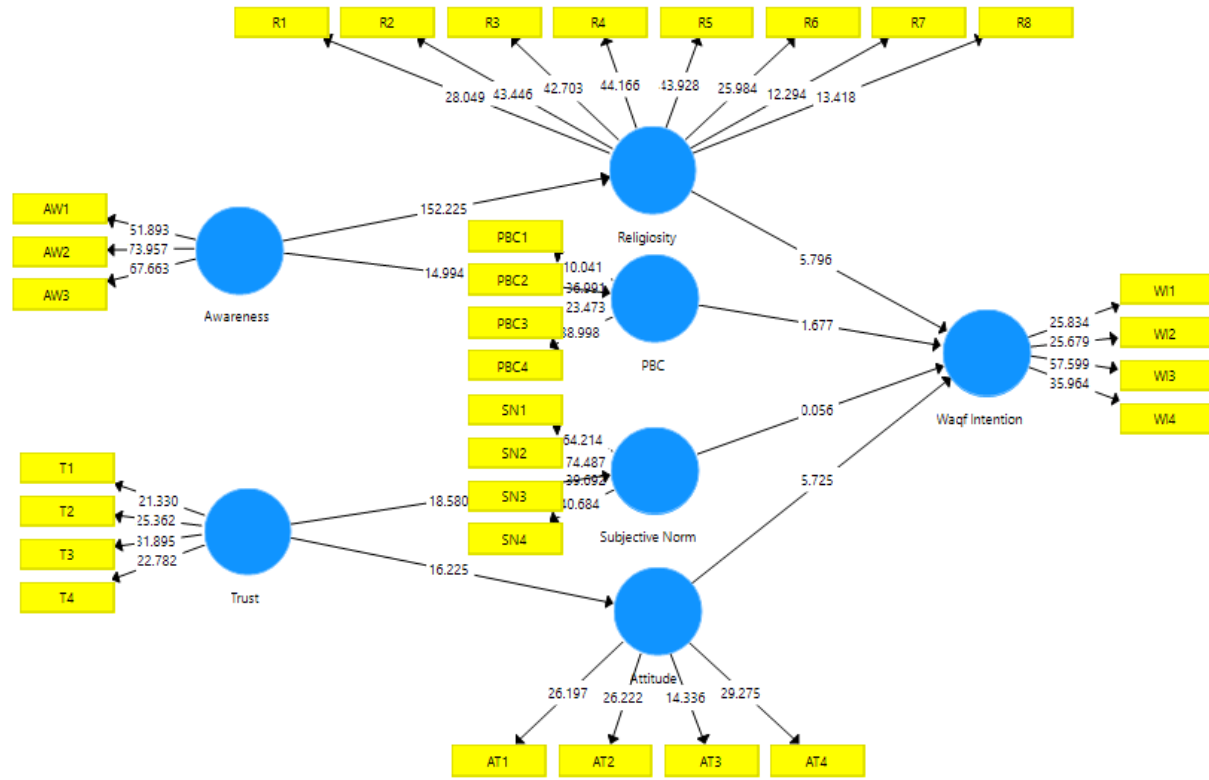
Figure 1: Output of Inner Model Evaluation; Source: Processed Data (2022) R Square